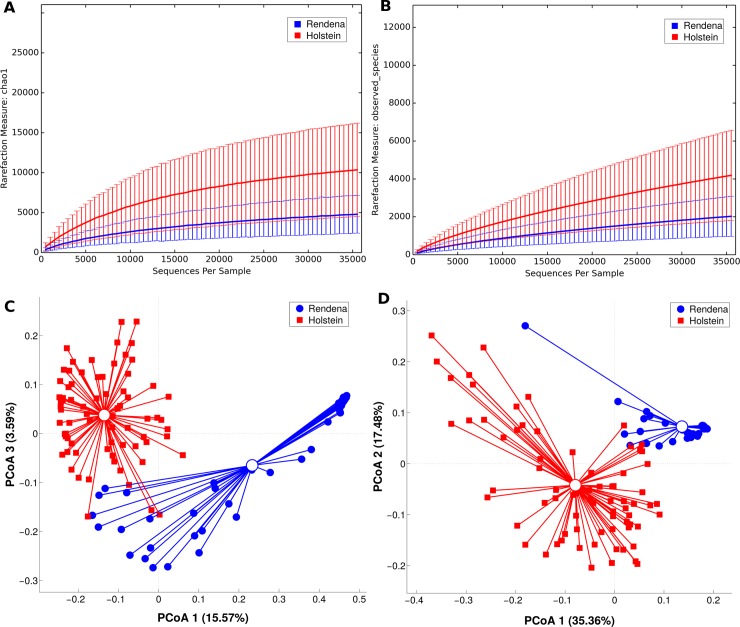
Alpha and beta-diversity among HF (red) and REN (blue).Rarefaction at 35,959 sequences per sample. Alpha-diversity average indexes (plus standard error bars) for phylogenetic diversity Chao1 (A) and observed species (B) are reported for HF and REN milk samples. Diversity among breeds is statistically significant in all the metrics (including Shannon index, not shown), p-value = 0.001. Beta-diversity analysis is represented by PCoA graphs of weighted UniFrac distance between HF and REN along the principal components (C-D). Each dot represents a single quarter milk sample, while the centroids represent their average value. Separation among the centroids is statistically significant (p-value < 0.001). Percent variance accounted for by the first, second and third principal component is shown along the axis.